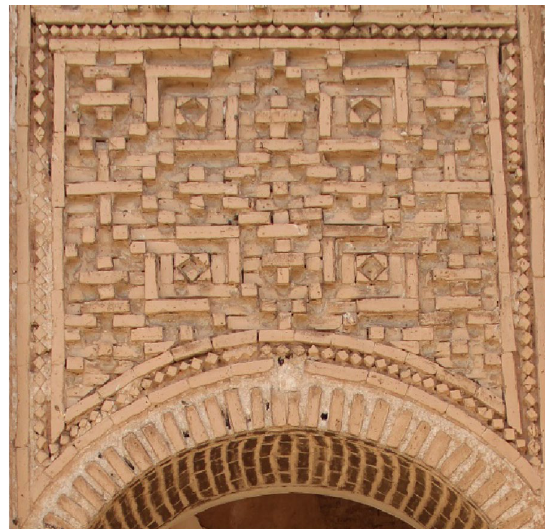
Fig. 10 Toffah Xowun in Alidad ghasemi house. Source: MCHT of Dezful